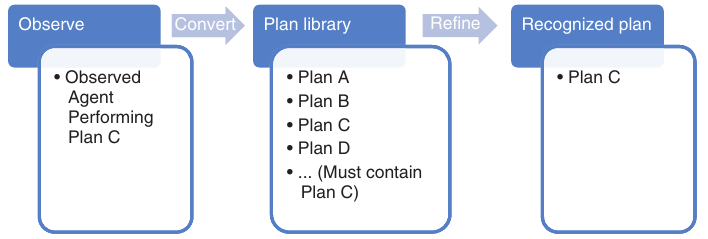
Figure 2. Plan Recognition